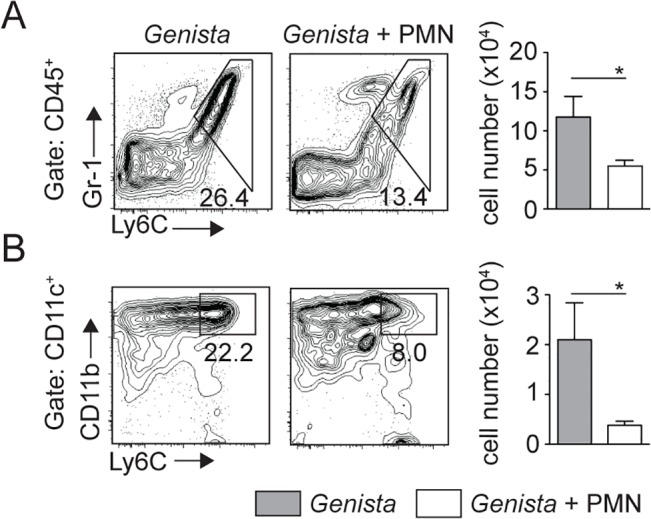
Injection of WT neutrophils in Genista mice reduces the otherwise observed monocyte recruitment at the site of L. mexicana inoculation.
Genista mice were either inoculated i.d. with 106 metacyclic L. mexicana-DsRed or co-inoculated i.d. with 106 C57BL/6 sorted neutrophils. Ears were recovered 3 days post infection, processed and analyzed by flow cytometry. (A) Representative flow cytometry profiles of ear-derived CD45+Gr1+Ly6C+ inflammatory monocytes and of (B) CD45+CD11c+Ly6C+CD11b+ MoDCs are depicted with the corresponding quantitation in cell numbers shown in the bar graphs. Data presented as the mean number of cells ± SEM for n = 6/group. Results are representative of 4 or more independent experiments. * p<0.05.